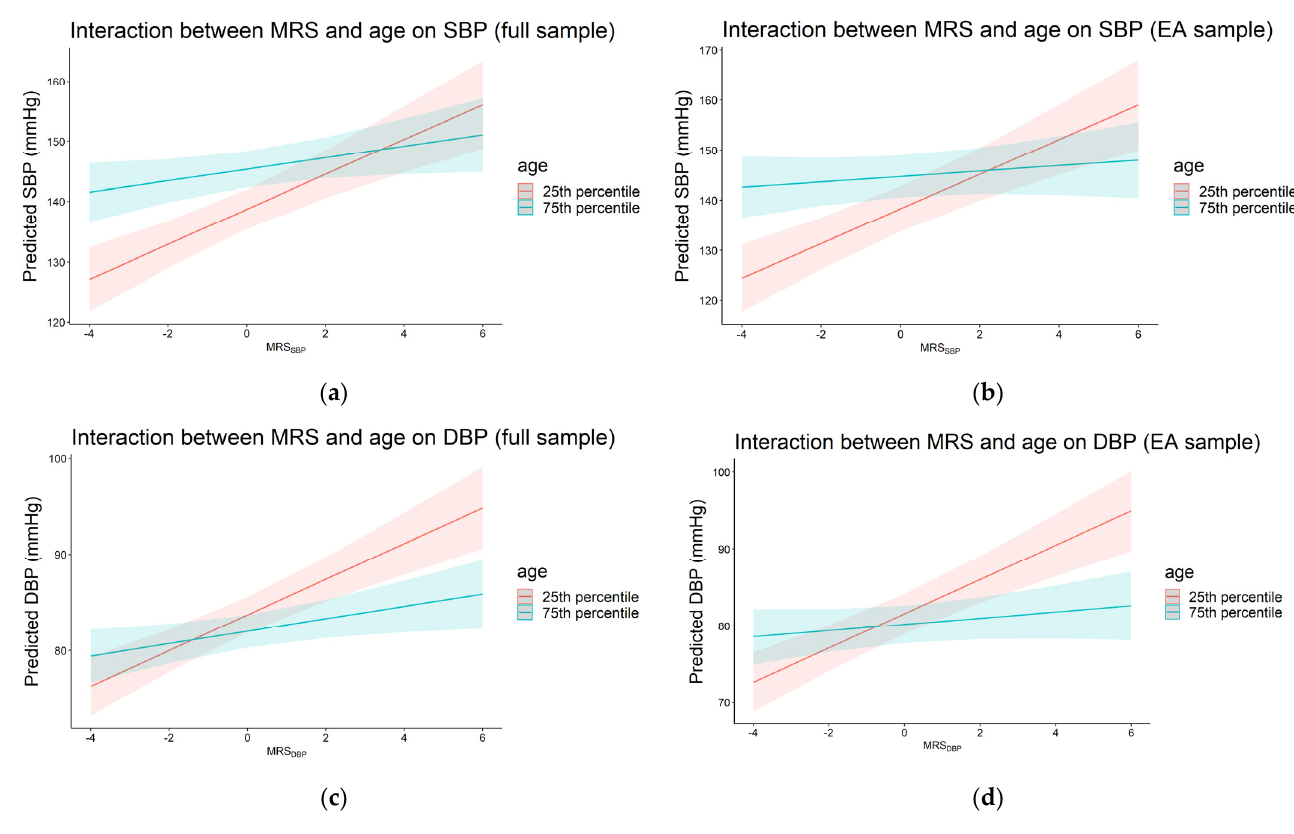
Figure 2. Plots of predicted systolic ( a , b ) and diastolic ( c , d ) blood pressure by MRS SBP at the 25th and 75th percentiles of age in the full and European ancestry samples ( p interaction < 0.05). The 25th and 75th percentiles were equivalent to 65.0 and 77.5 years (full sample) and 64.0 and 79.0 years (European ancestry sample), respectively.